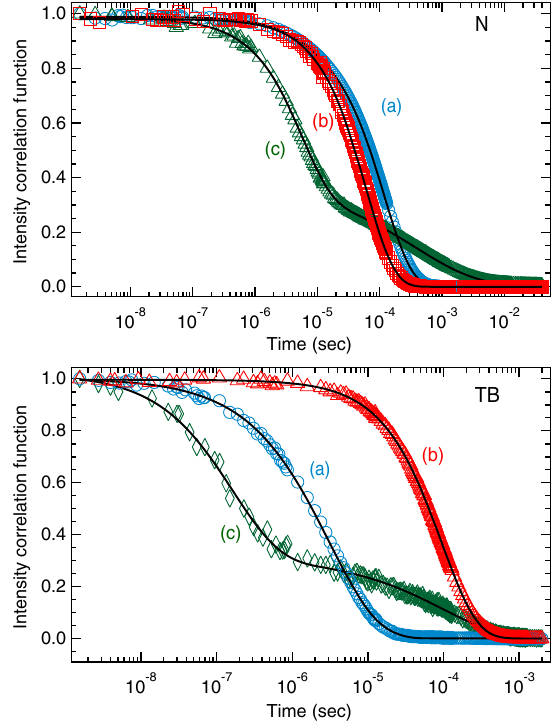
TB FIG. 4. Top panel: Normalized homodyne DLS correlation functions taken in the nematic phase of the studied LC mixture ¼ 16 . 2 °C and angles for (a) geometry G2 with T − T TB phase. (b) Under an θ ¼ 15 °, θ ¼ 40 °, (b) G1 with T − T ¼ 6 . 0 °C and θ ¼ 0 °, TB i s i TB ¼ 60 °, and (c) G2 with T − T ¼ 16 . 2 °C and θ ¼ 15 °, θ ¼ θ s i s TB 0 ° ( “ dark ” director geometry). Solid lines represent fits to a single region is exponential decay, except for (c), which is fit to a double TB exponential with the slower component stretched. Bottom panel: Normalized correlation data taken in the N phase for (a) geom- TB ¼ − 0 . 93 °C and θ ¼ 15 °, θ ¼ 40 °, (b) G1 etry G2 with T − T i s TB ¼ − 1 . 1 °C and θ ¼ 0 °, θ ¼ 60 °, and (c) G2 with with T − T i s TB T − T ¼ − 2 . 5 °C and θ ¼ 35 °, θ ¼ 0 ° (dark director geom- i s TB etry). Solid lines are single exponential fits, except for a double TB exponential in